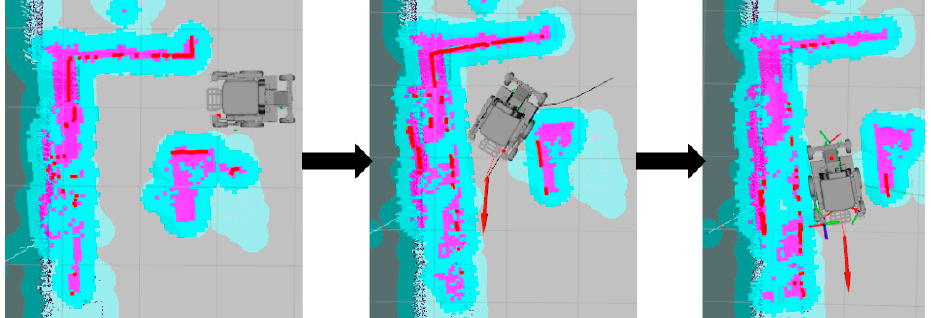
Figure 19. Curve driving test driving screen in narrow indoor corridor.